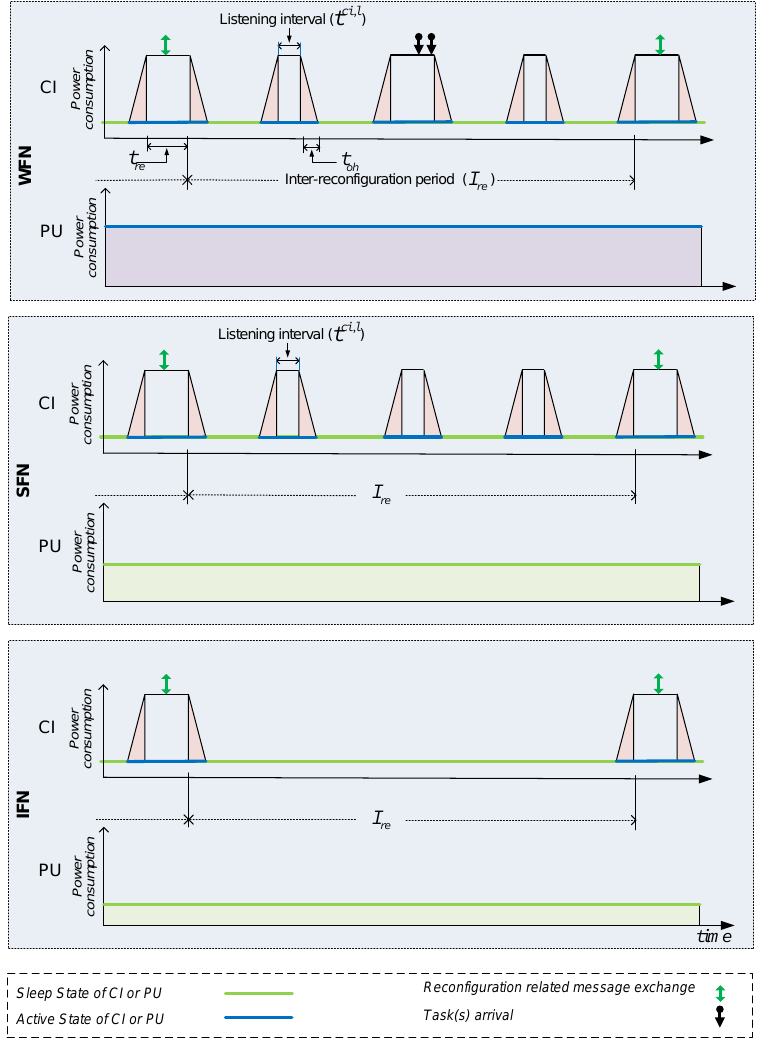
Figure 3. Energy-saving operations of a WFN, SFN and IFN in the proposed